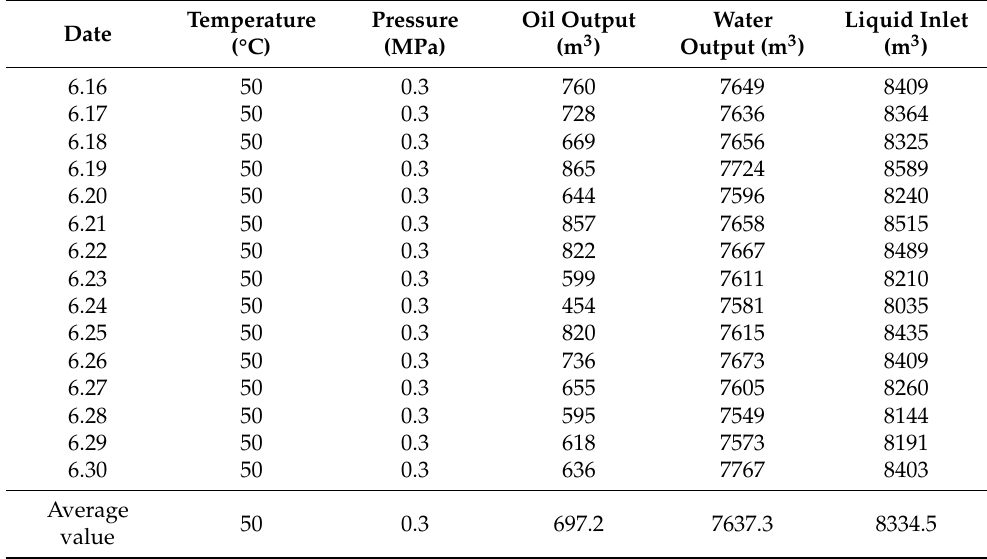
Table 2. Liuzan Union Station three-phase separator 15th operation data record